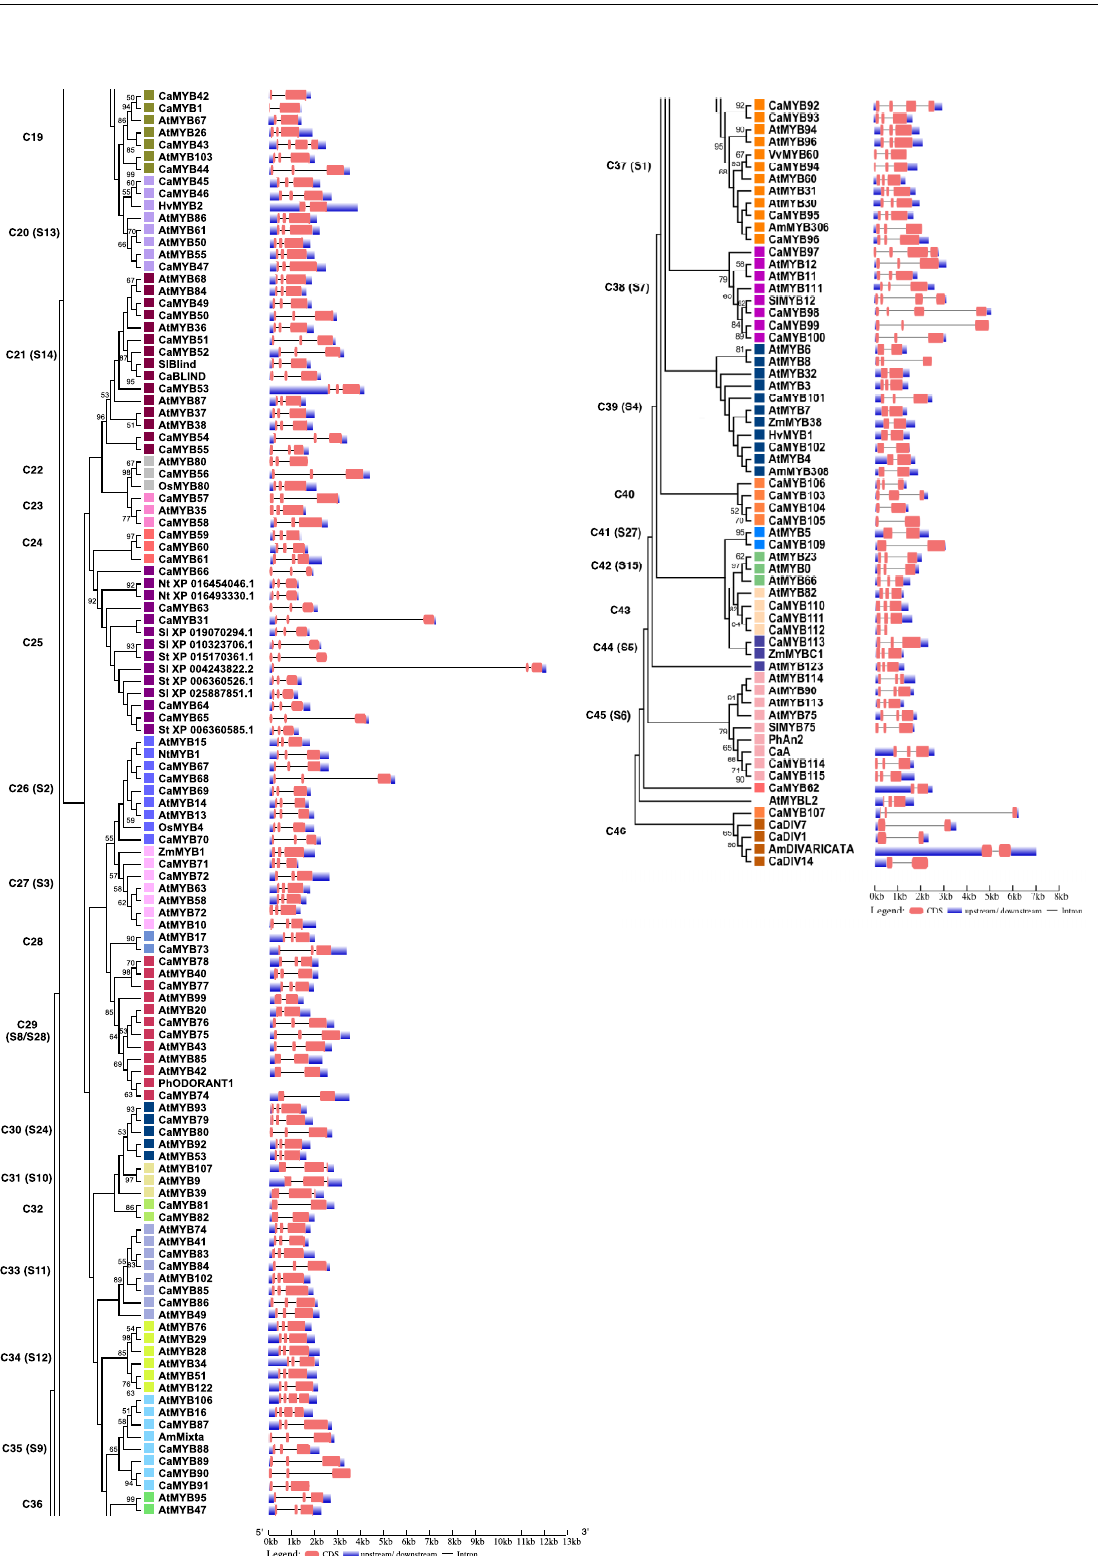
Figure 3. Exon-intron structures of CaMYB genes. Red bars represent exons and solid lines correspond to introns. Upstream and downstream regions are indicated by the blue boxes. The scale on the bottom is in kilobases (Kb). Ca: Capsicum annuum ; Cb: Capsicum baccatum ; Cc: Capsicum chinense ; At: Arabidopsis thaliana ; Sl: Solanum lycopersicum ; St: Solanum tuberosum ; Nt: Nicotiana tabacum ; Am: Antirrhinum majus ; Os: Oryza sativa ; Mm: Mus musculus ; Hv: Hordeum vulgare ; Zm: Zea mays ; Ph: Petunia hybrida ; Vv: Vitis vinifera . The protein IDs are listed in Tables S1 and